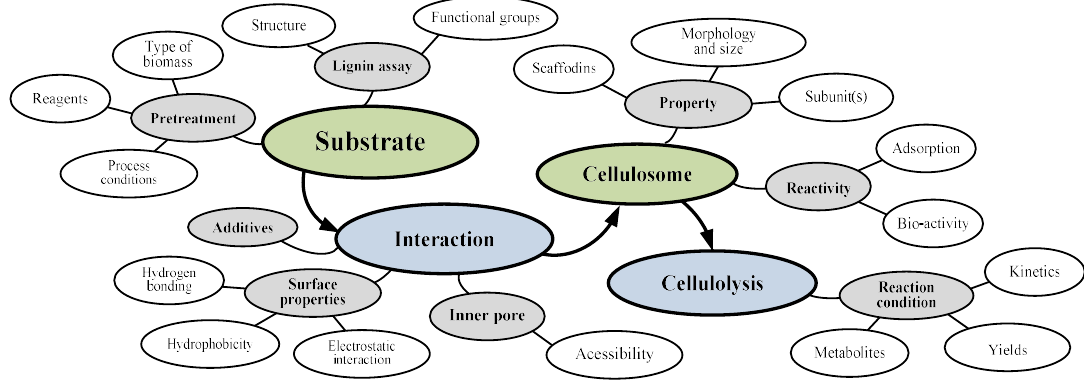
Figure 3. Interactions between cellulosome and substrate-related factors.